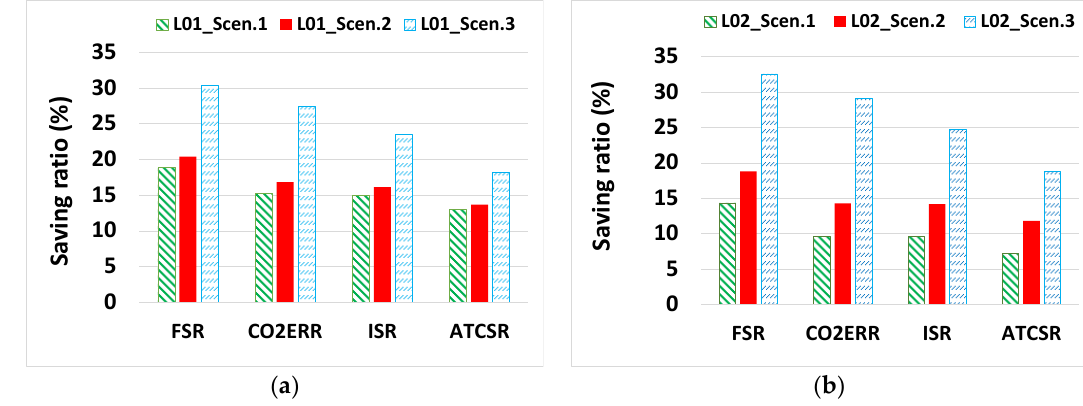
Figure 9. Fuel saving ratio ( FSR ), CO 2 emission reduction ratio ( CO2ERR ), annualized total cost saving ratio ( ATCSR ) and integrated savings ratio ( ISR ) for the design scenarios (Scen. 1 to 3) and the two load types; L01 ( a ) and L02 ( b ).